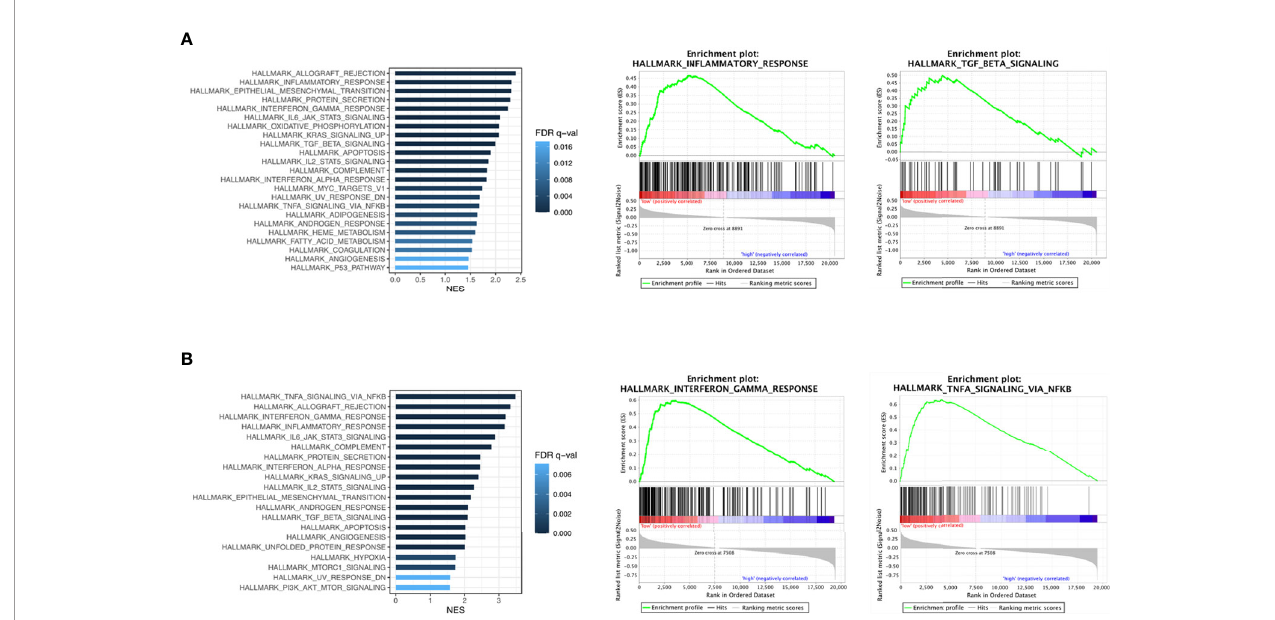
FIGURE 2 | Immune related pathways enriched in RBM10 de fi cient LUADs. (A) Enriched functional pathways in RBM10 de fi cient LUADs in the TCGA_LUAD cohort. (B) Pathways enriched in RBM10 de fi cient LUADs in the CHOICE_ADC